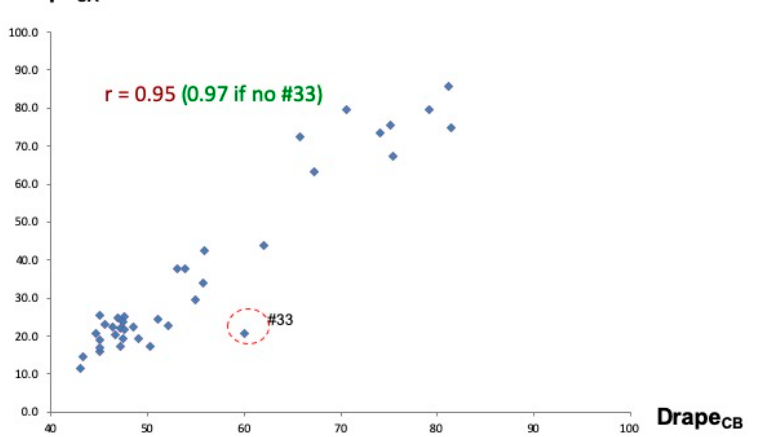
Figure 5. Cusick drape Data vs. UCD and Cotton (n = 38) (data not available for Samples #9 and #10).